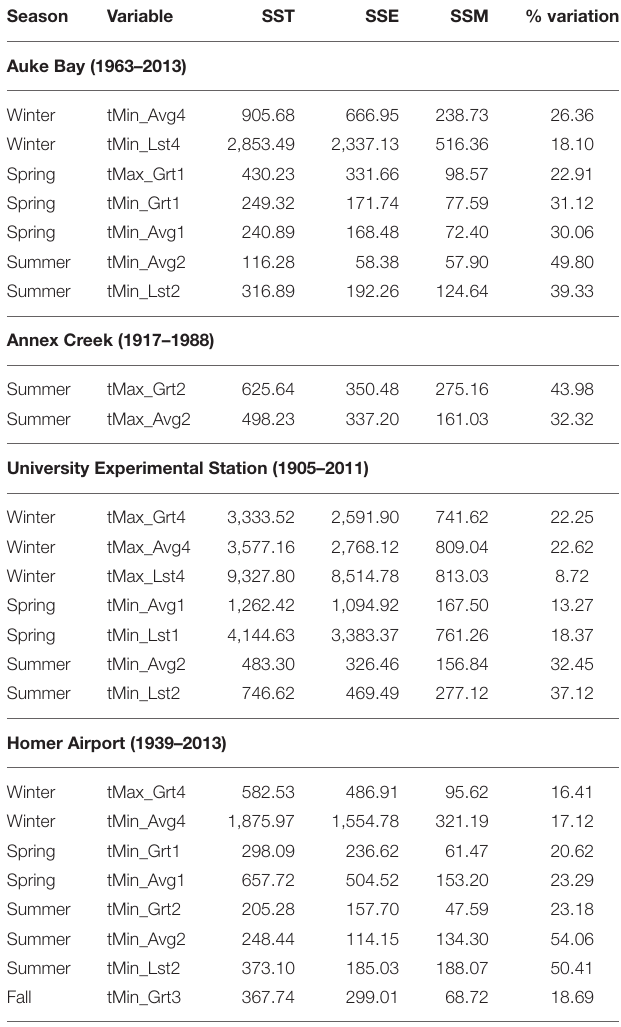
TABLE 6 | Values of total sum of squares (SST), sum of squares of squares due to error (SSE), sum of squares due to model (SSM), and %Variation = (SSM/SST) × 100 for all variables in all seasons with at least one significant change-point at stations AB, AC, UES, and HA of